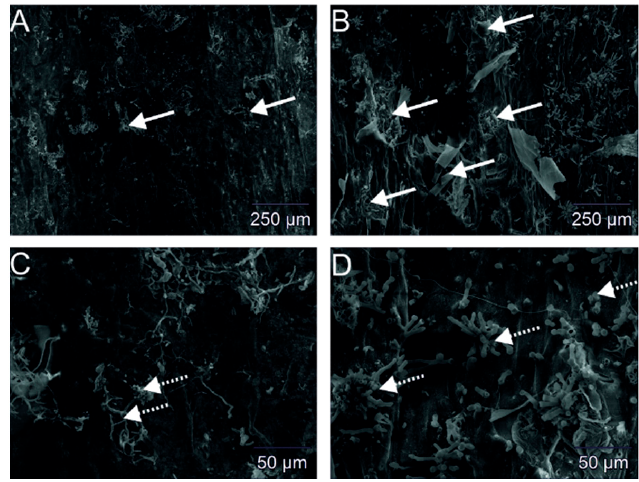
Figure 6. SEM images of the control sample and the sample disintegrated for 5 min (( A , B ) control sample, ( C , D ) disintegrated sample).